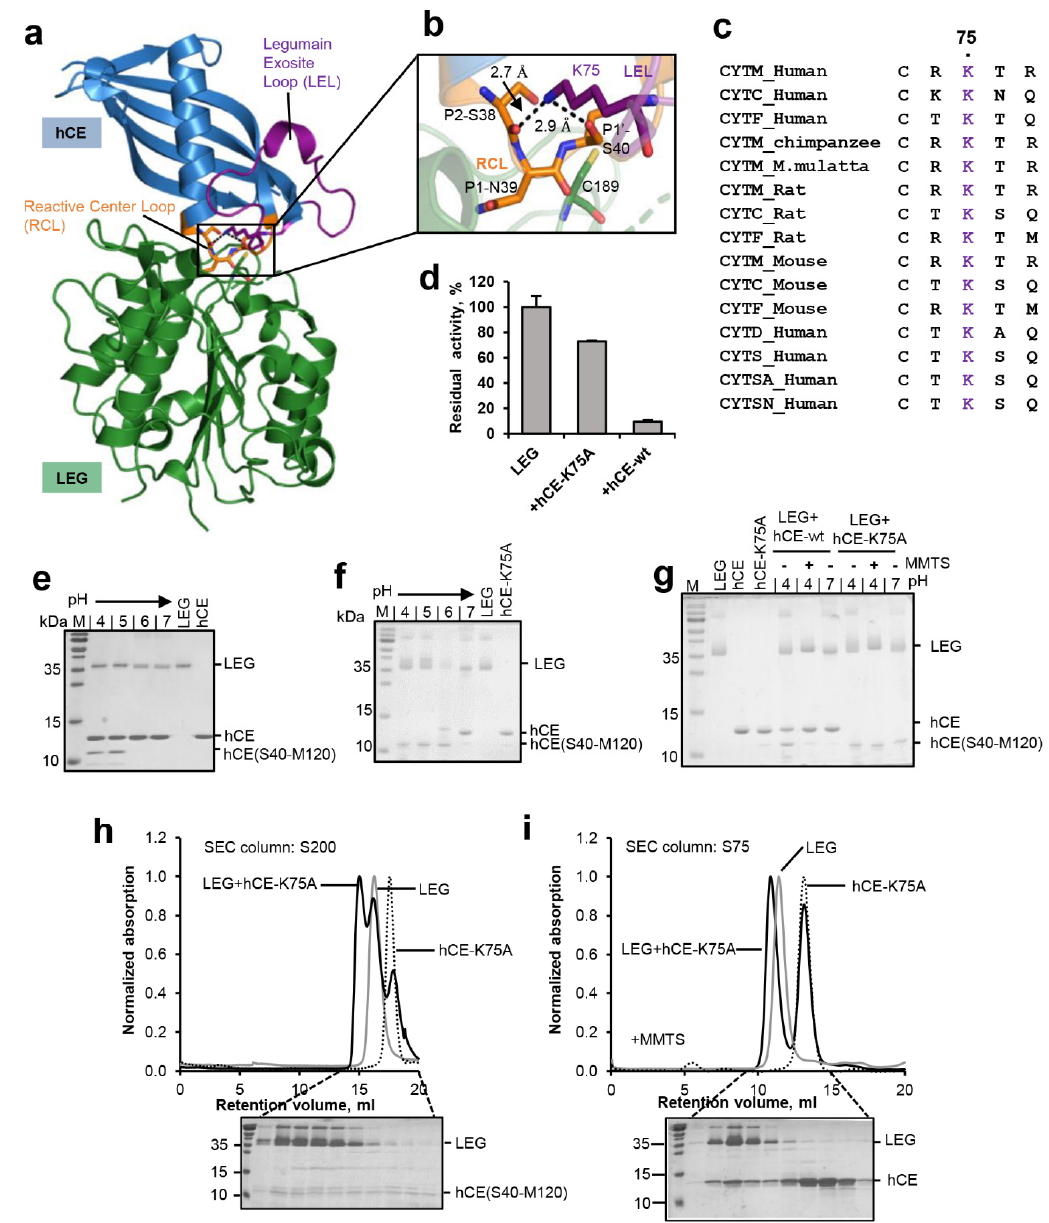
Figure 5. Substrate conformation is critical for hydrolysis and ligation. ( a ) Structure of legumain (LEG, green) in complex with cystatin M/E (hCE, blue, pdb 4n6o). The reactive center loop (RCL) is shown in orange, the legumain exosite loop (LEL) in purple. ( b ) Zoom-in view on the RCL (orange). The catalytic Cys189 is indicated in green sticks, the P2–P1 ′ residues on the RCL as orange sticks and Lys75 on the LEL as purple sticks. ( c ) Sequence alignment of family 2 cystatins C, D, M/E, F, S, SA, and SN. Lys75 is highlighted in purple. ( d ) Residual activity of legumain measured as turnover of the AAN-AMC substrate upon incubation with wild-type cystatin M/E (hCE-wt) or the cystatin M/E-K75A (hCE-K75A) mutant at pH 5.5. ( e ) SDS-PAGE gel after incubating legumain with wild-type cystatin M/E at indicated pH values for 1 h at 37 °C. ( f ) Same as ( e ) but using the cystatin M/E-K75A mutant. The C-terminal cleavage product hCE(S40-M120) is indicated. ( g ) Incubation of legumain with a 4-fold molar excess of cystatin M/E or the cystatin M/E-K75A mutant at pH 4.0 led to processing of the cystatin after the P1-Asn39 residue. Subsequent incubation at pH 7.0 or addition of S-methyl methanethiosulfonate (MMTS) led to re-ligation of the Asn39-Ser40 peptide bond in wild-type cystatin M/E but not in the cystatin M/E-K75A mutant. ( h ) Legumain was